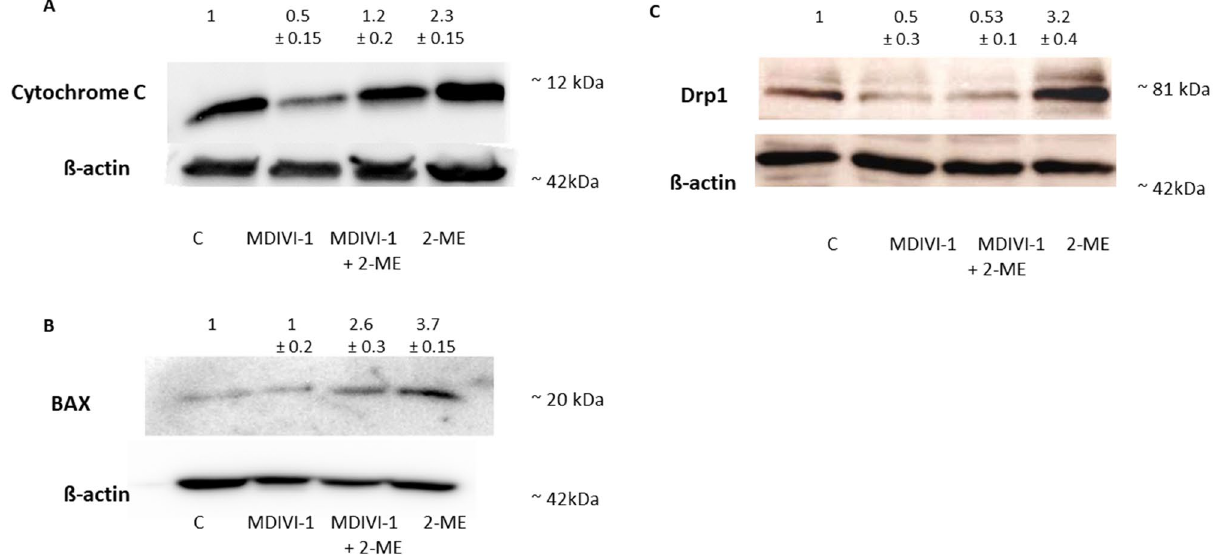
Figure 5. MDIVI-1 decreases the 2-ME-mediated upregulation of Drp1, BAX and cytochrome C. ( A ) Pre- treatment with 5 µM MDIVI-1 for 6 h decreases 2-ME-mediated upregulation of cytochrome C ( A ), BAX ( B ) and Drp-1 ( C ) proteins level in OS 143B cells evaluated by Western blotting. Densitometric analysis of ratio cytochrome C/β-actin, BAX/β-actin, Drp1/β-actin were performed using Quantity One 4.5.2 software. The presented immunoblots representative from one membrane are